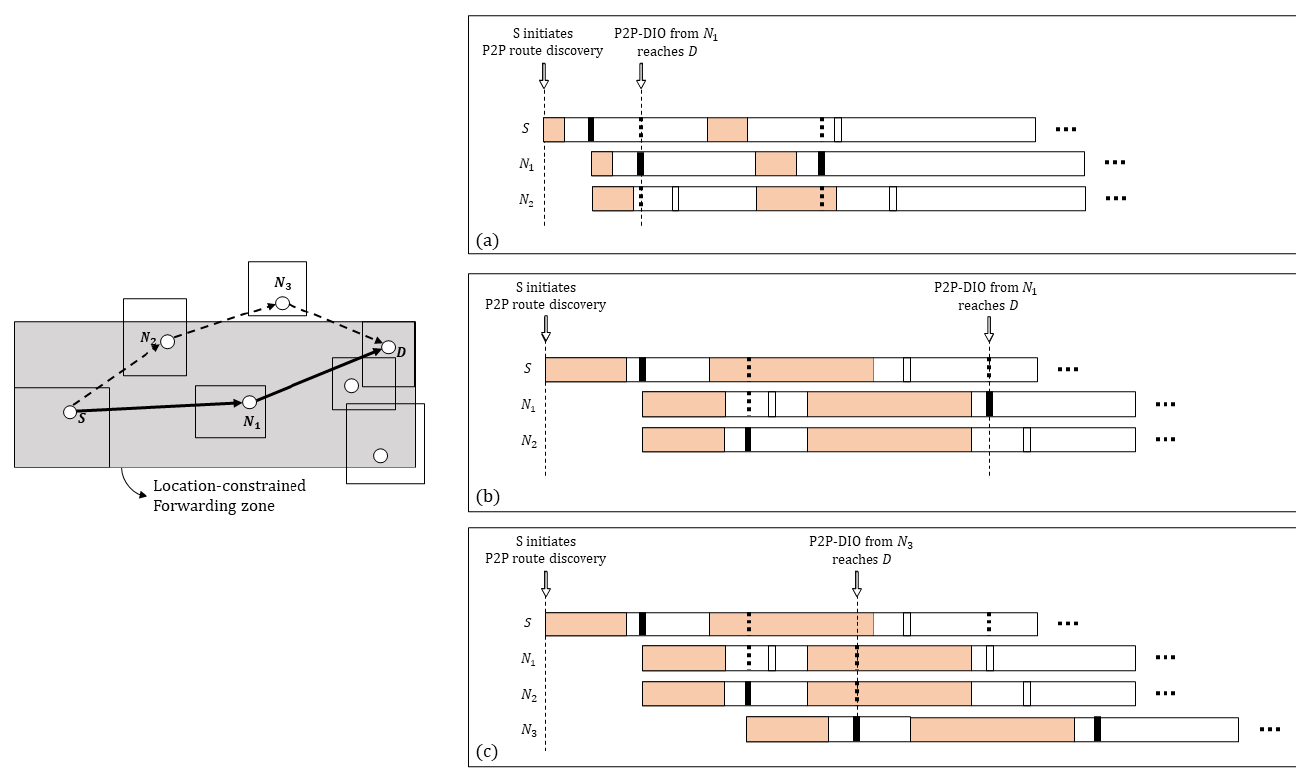
Figure 5. Trickle operations of ( a ) Collision Avoidance Geographic P2P-RPL, ( b ) P2P route discovery with only the location-constrained forwarding zone and ( c ) P2P-RPL, k =